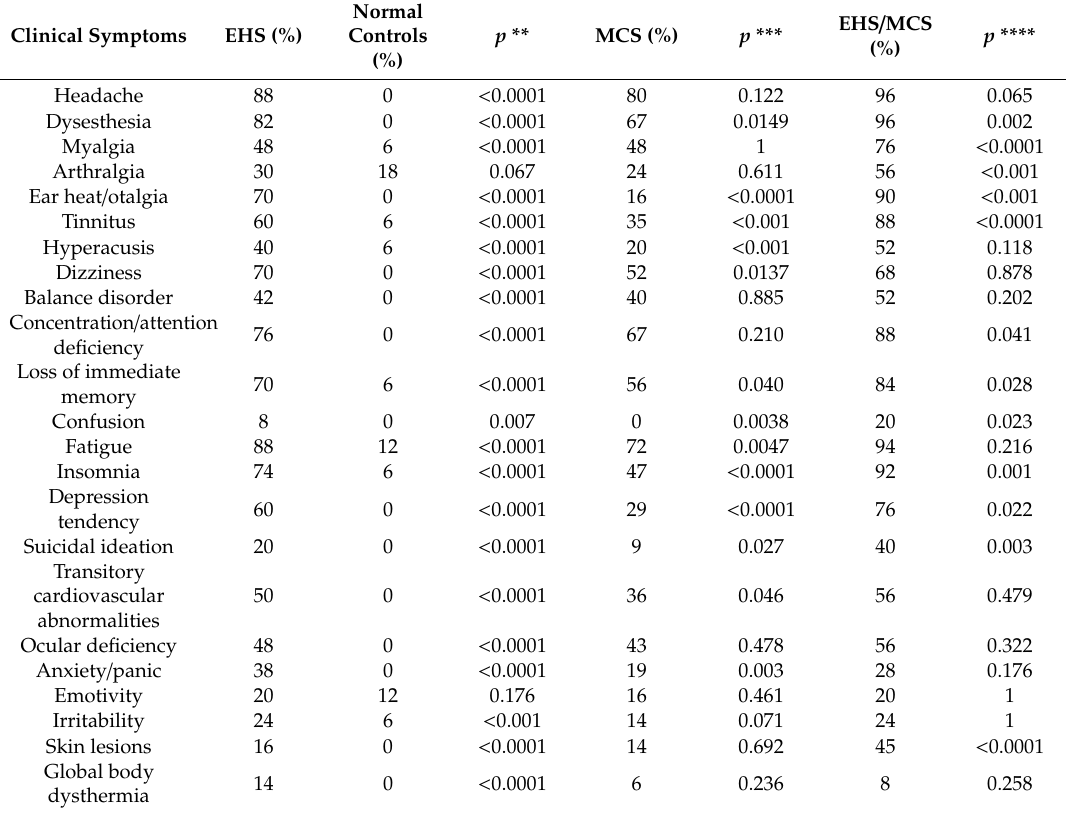
* These data result from the clinical analysis of 150 consecutive clinically evaluable cases issued from the database including an already published series of EHS and / or MCS patients who were investigated for biological markers [10]. Symptoms in EHS self-reported patients were compared with symptoms obtained from a series of 50 apparently normal subjects used as controls. These symptoms were also compared to those occurring in MCS and EHS / MCS self-reported patients. Percentage of patients with symptoms were compared by using the chi-square independence test. **Statisticaldi ff erencebetweenEHSself-reportedpatientsandnormalcontrols. ***Statisticaldi ff